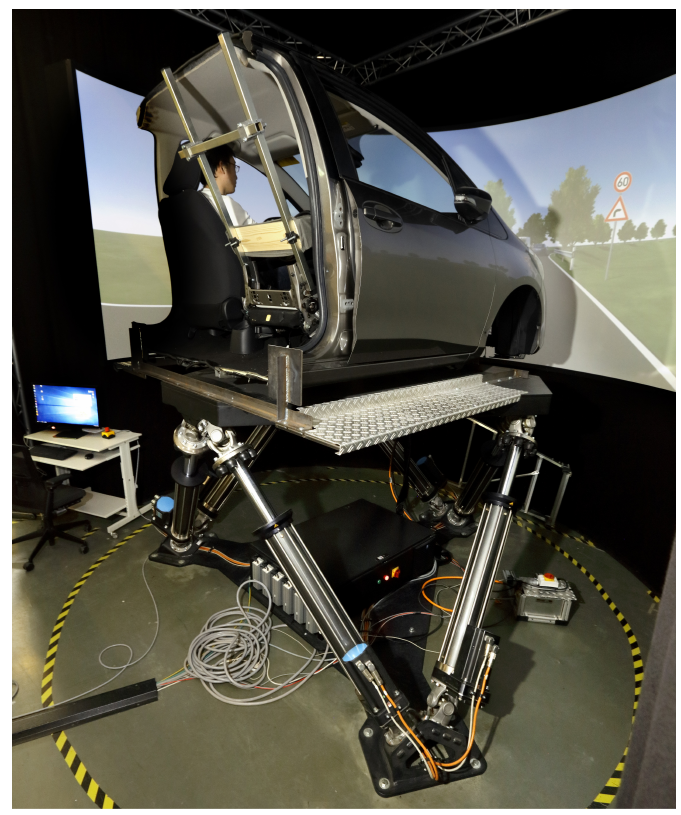
Figure 7. The Delft Advanced Vehicle Simulator.